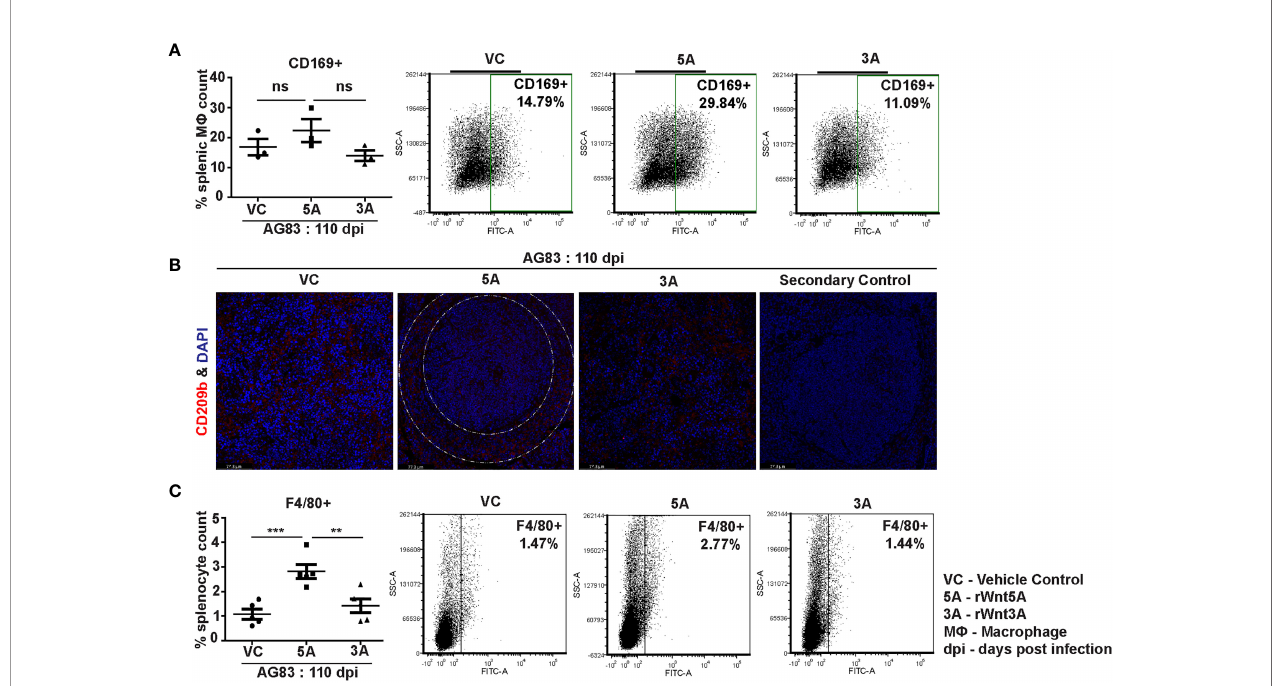
FIGURE 7 | rWnt5A supports preservation of splenic macrophages after L. donovani infection. (A) Graphical representation of increased percentage of CD169 + splenic marginal metallophillic macrophages associated with rWnt5A treatment as compared to controls, with representative examples. (B) Preservation of CD209b + (in red) splenic marginal zone macrophages (marginal zone area denoted by white dashed concentric lines) in association with treatment of rWnt5A, but not rWnt3A or VC, as revealed by confocal microscopy (under 40X objective/oil immersion). DAPI stain represents nucleus. (C) Increased percentage of F4/80 + macrophages in rWnt5A set as compared to vc and rWnt3A treated set, with representative examples. Statistical analysis was performed with the unpaired t-test. Data are presented as mean ± SEM. Signi fi cance was annotated as follows: ** p ≤ 0.005, *** p ≤ 0.0005, ns, not signi fi cant, n=3 to 5 (per